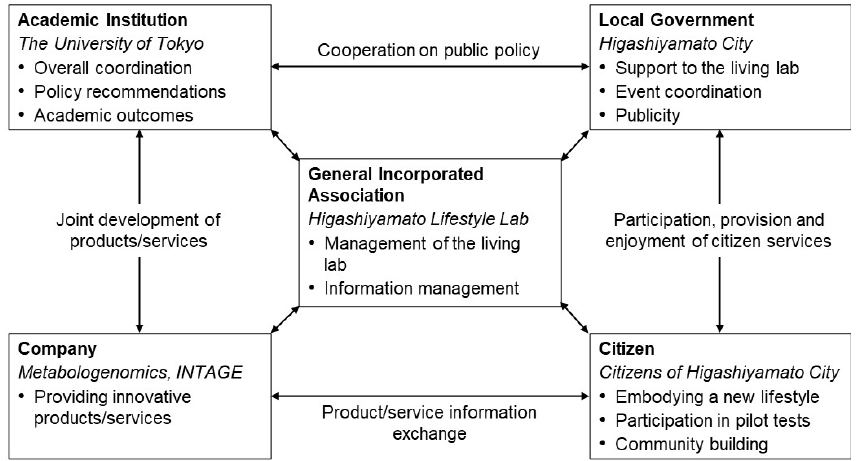
Figure 1. Implementation structure of this project. Bold indicates the sector involved; italics indicate the actors in this case.